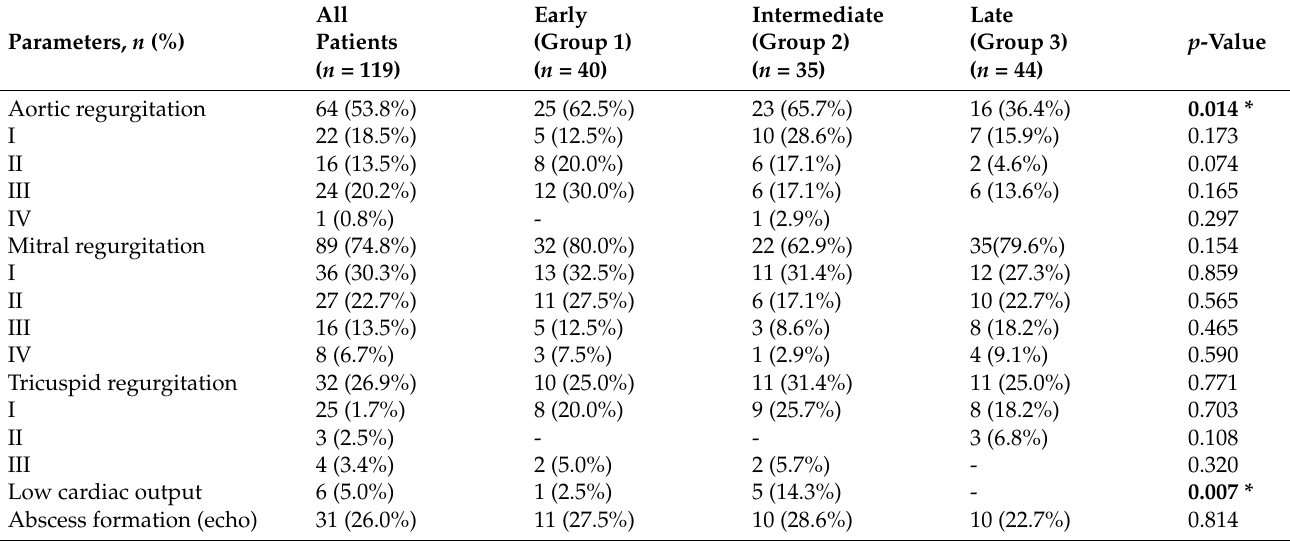
Table 2. Indications for surgery ( n =